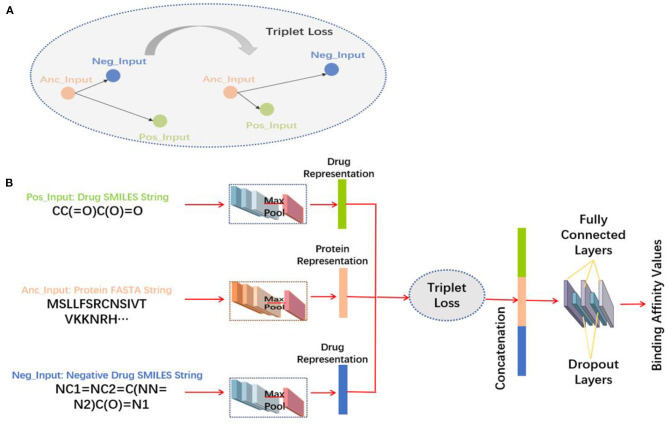
Structure diagram of the 3-Tunnel DNN model. (A) Diagram of triplet loss and (B) flowchart of the 3-Tunnel DNN model.